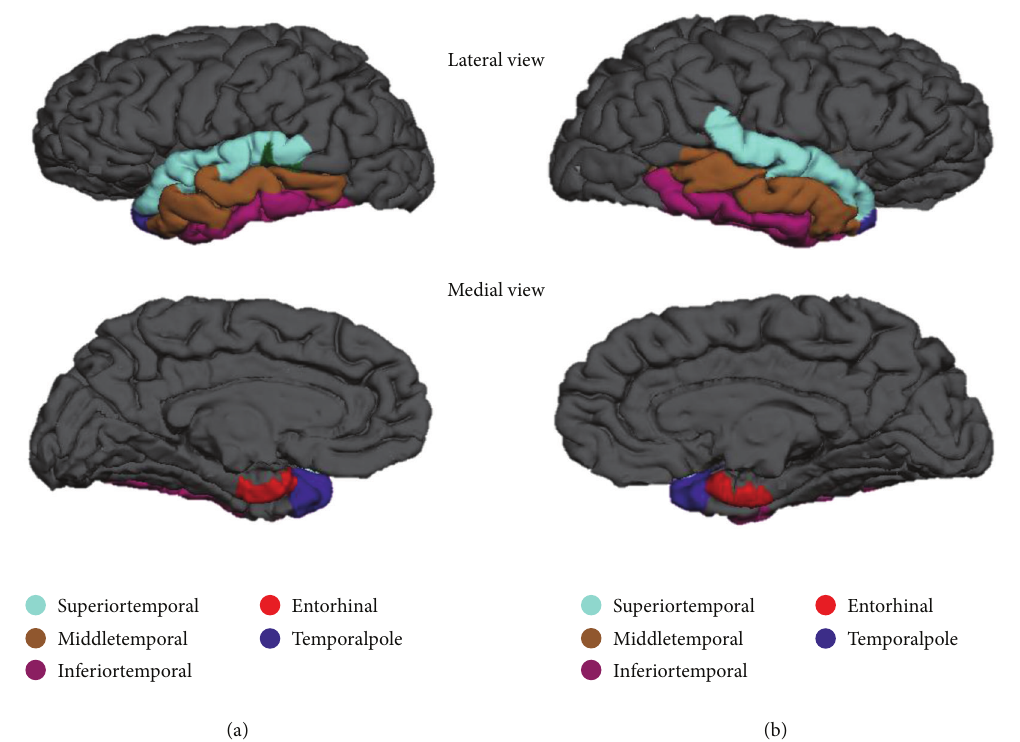
Figure 2: Representation of the top 5 significant cortical thickness based on raw data in Table 8. (a) Left hemisphere (b) Right